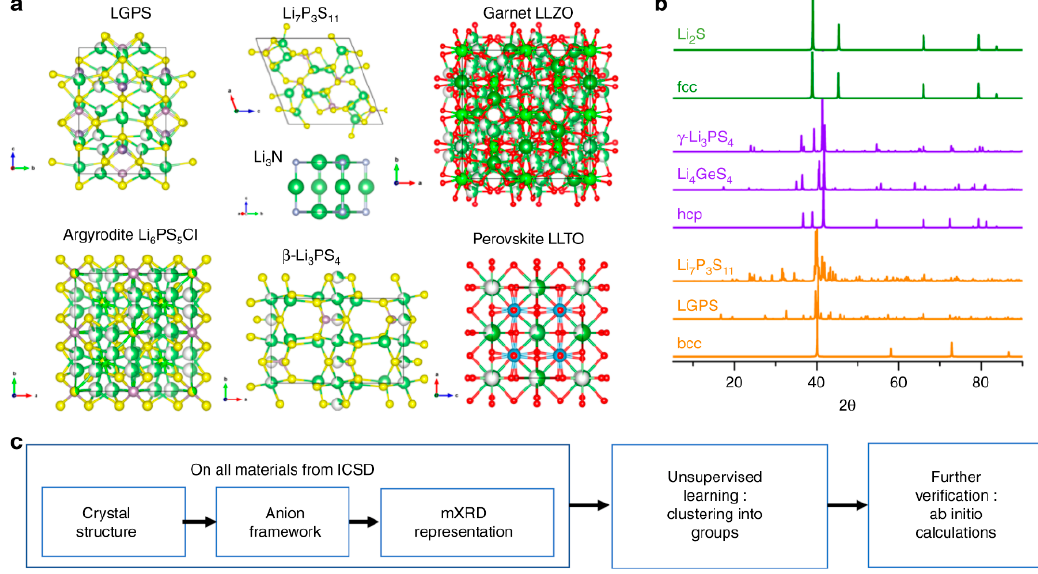
Figure 5. Schematics of the unsupervised discovery of solid-state Li-ion conductors. ( a ) Crystal structures of known Li-ion conductors, showing a large diversity of design and chemistry. ( b ) mXRD patterns of selected materials in comparison to those of ideal fcc (face-centered cubic), hcp (hexagonal close-packed), bcc (body-centered cubic) lattices. ( c ) Workflow of unsupervised learning guided discovery of Li-ion conductors. Reprinted from Reference [73] with permission from Springer Nature.